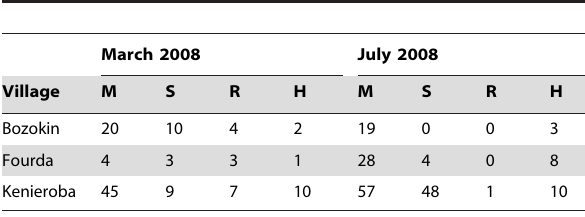
Table 1. Species and Molecular Form Composition in Fourda, Bozokin, and Kenieroba. a,b